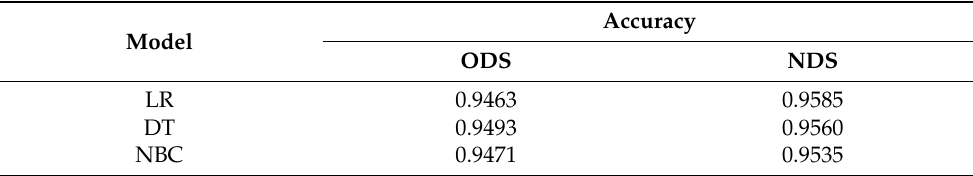
Table 6. Accuracy of stacking model with ODS and NDS.